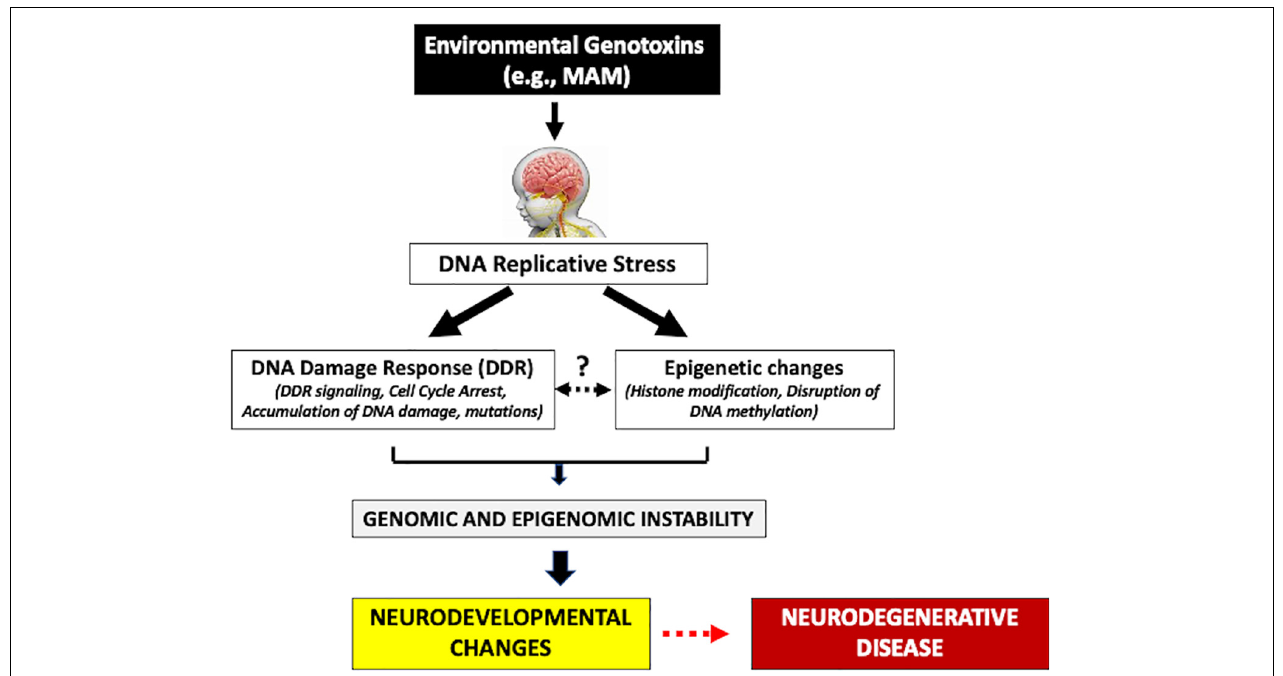
FIGURE 1 | Human exposure to environmental genotoxins (e.g., methylazoxymethanol, MAM) during brain development (fetal/post-natal, childhood) may induce genomic/epigenomic instability that leads to sequential molecular changes culminating in later-life progressive neurodegenerative